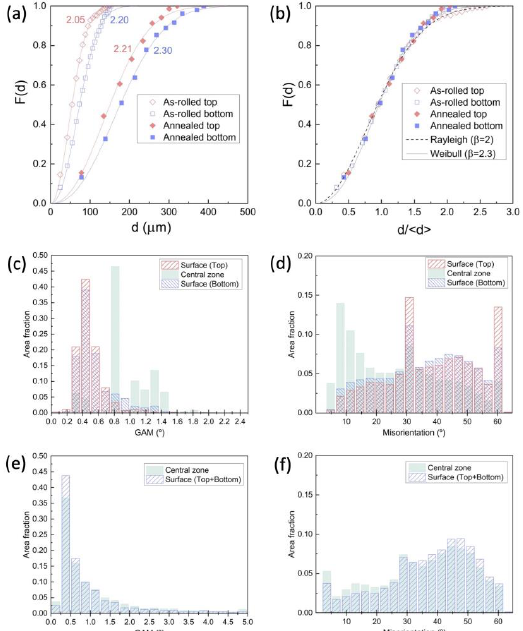
Figure 10. Sample R2 with ε = 1.00. ( a ) Grain size cumulative distribution function in as-rolled and annealed samples. Fitted values by Weibull function ( 𝛽 value is indicated for each curve). ( b ) Comparison of cumulative distribution functions. Grain average misorientation (GAM) and Misorientation histograms in ( c , d ) as-rolled and ( e , f ) annealed conditions.